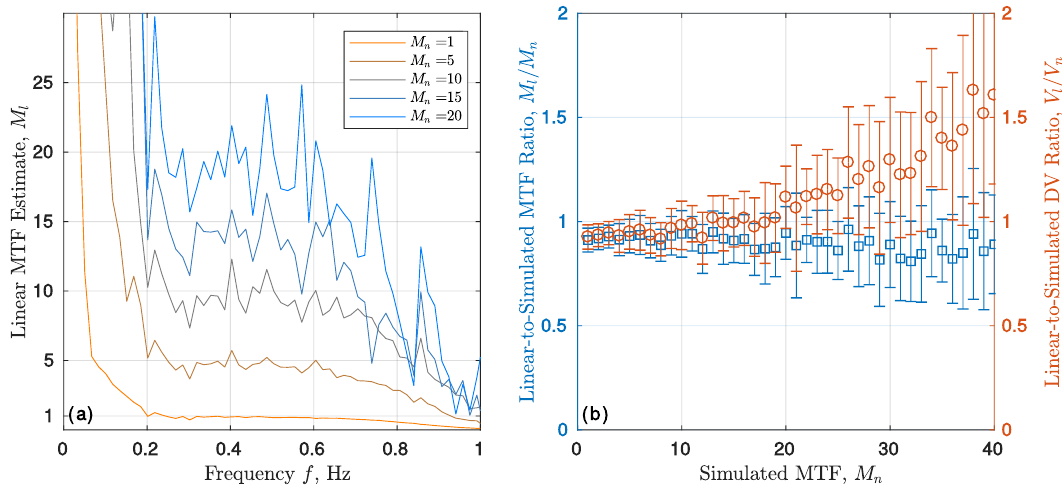
Figure 12. ( a ) Linear MTF estimated using Equation (9) for the non-linearly simulated NRCS for various M = M n in Equation (10); ( b ) Left y-axis: ratio of linear MTF estimate, M = M l in Equation (9), averaged at 0.2 Hz < f < 0.6 Hz to M n . Right y-axis: ratio of DV estimate based on linear MTF, V l in Equation (15), to the DV simulated using NLMTF, V n = v σ / σ in Equations (13) and